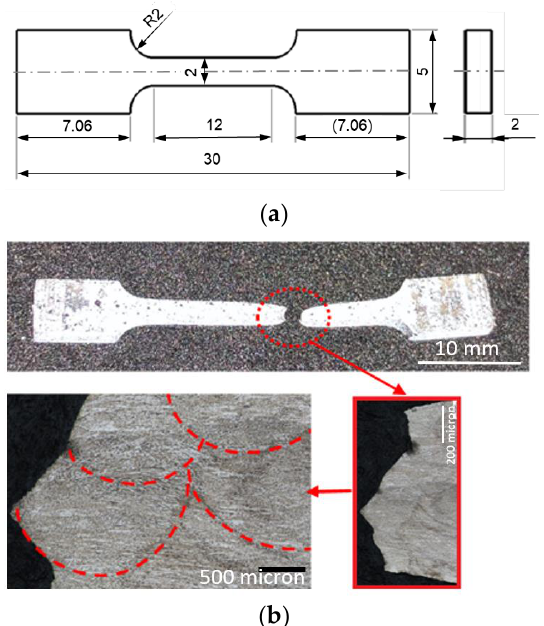
Figure 2. Schematic of tensile test samples: ( a ) geometry of the miniature tensile test samples (dimensions in mm): ( b ) enlarged fracture surface after failure in T 11 .